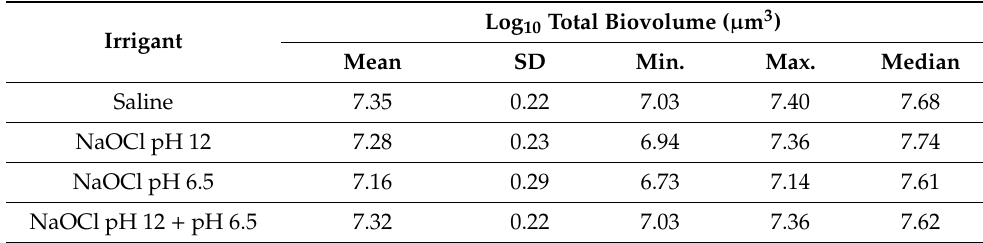
Table 1. Biovolume of the biofilm after exposure to the